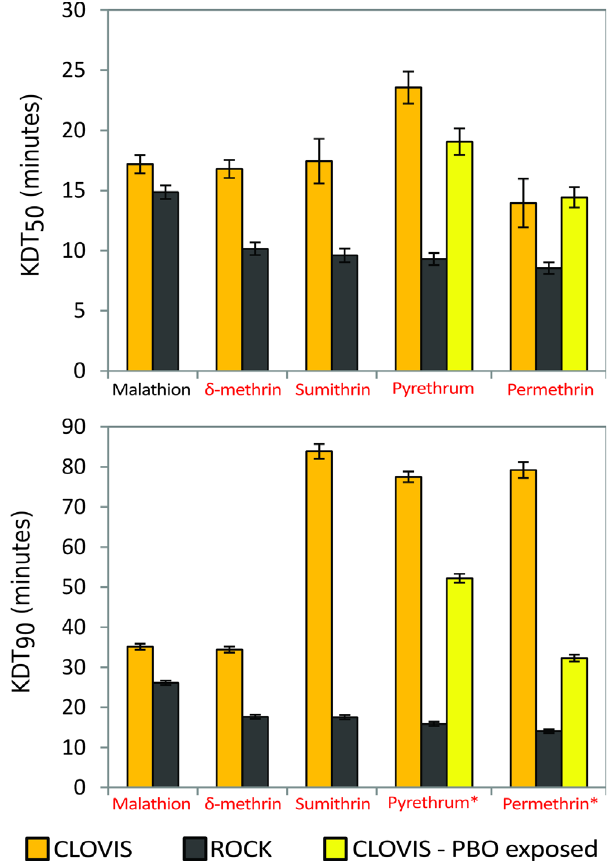
Figure 5. Box plot representation of median knock-down time (KDT and KDT ) and lethal time (LT and LT ) responses of 50 90 50 90 Ae. aegypti in bottle bio-assays to various insecticides with and without PBO. ROCK refers to the susceptible Rockefeller colony strain and CLOVIS refers to mosquitoes found in Clovis. Concentrations of insecticide each test bottle was coated with were: Malathion = 50µg/ml; Deltamethrin = 10µg/ml; Sumithrin = 20µg/ml; Pyrethrum = 15.6µg/ml; Permethrin = 15µg/ml. Significant differences in knock-down time or mortality between the CLOVIS and ROCK strains is indicated by red text (Wilcoxon rank sum test α <0.05 or P<0.0032). * Significant differences in knock-down time distribution between treatment with and without PBO (Wilcoxon rank sum test α <0.05 or P <